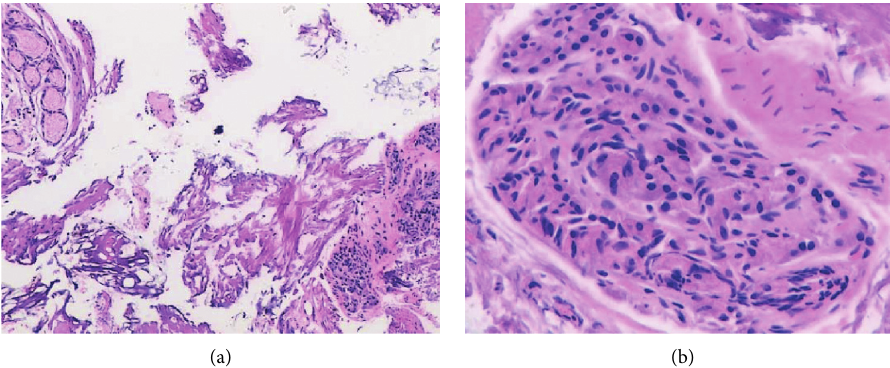
Figure 2: Hematoxylin and eosin stain showing PR: (a) PR (right) seen adjacent to gastric antral mucosa (left). (b) Pancreatic exocrine glands consistent with